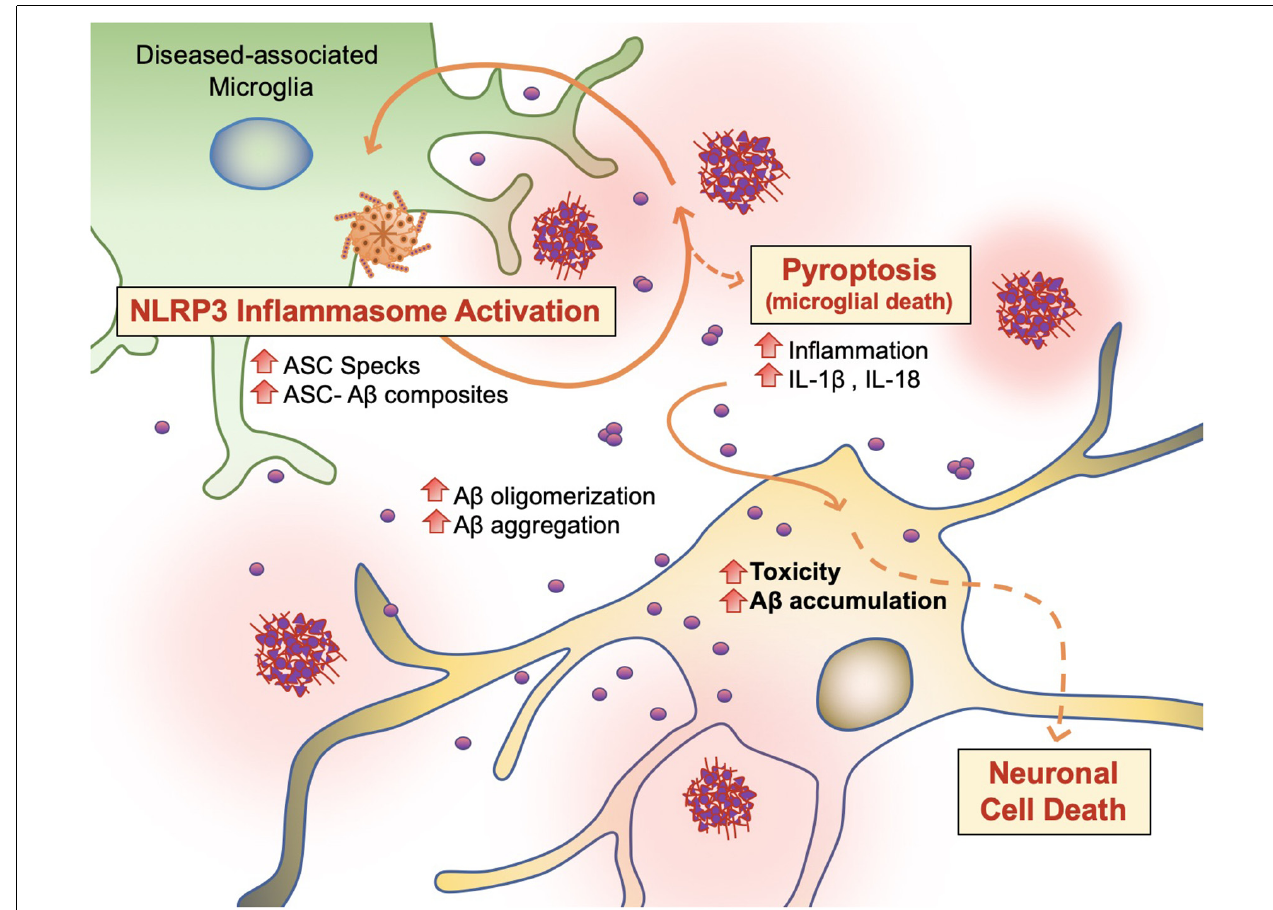
FIGURE 6 | Vicious cycling of A β . The NLRP3 inflammasome, which behaves as an intracellular sensor for DAMP signals, is activated in diseased microglia. Specifically, in the later stages of AD, microglia activation releases ASC specks, which bind to A β . ASC-A β composites reactivate the NLRP3 inflammasome via a vicious cycle, prolonging inflammation and the release of inflammatory cytokines such as interleukin IL-1 β and IL-18, consequently damaging neurons (Voet et al.,